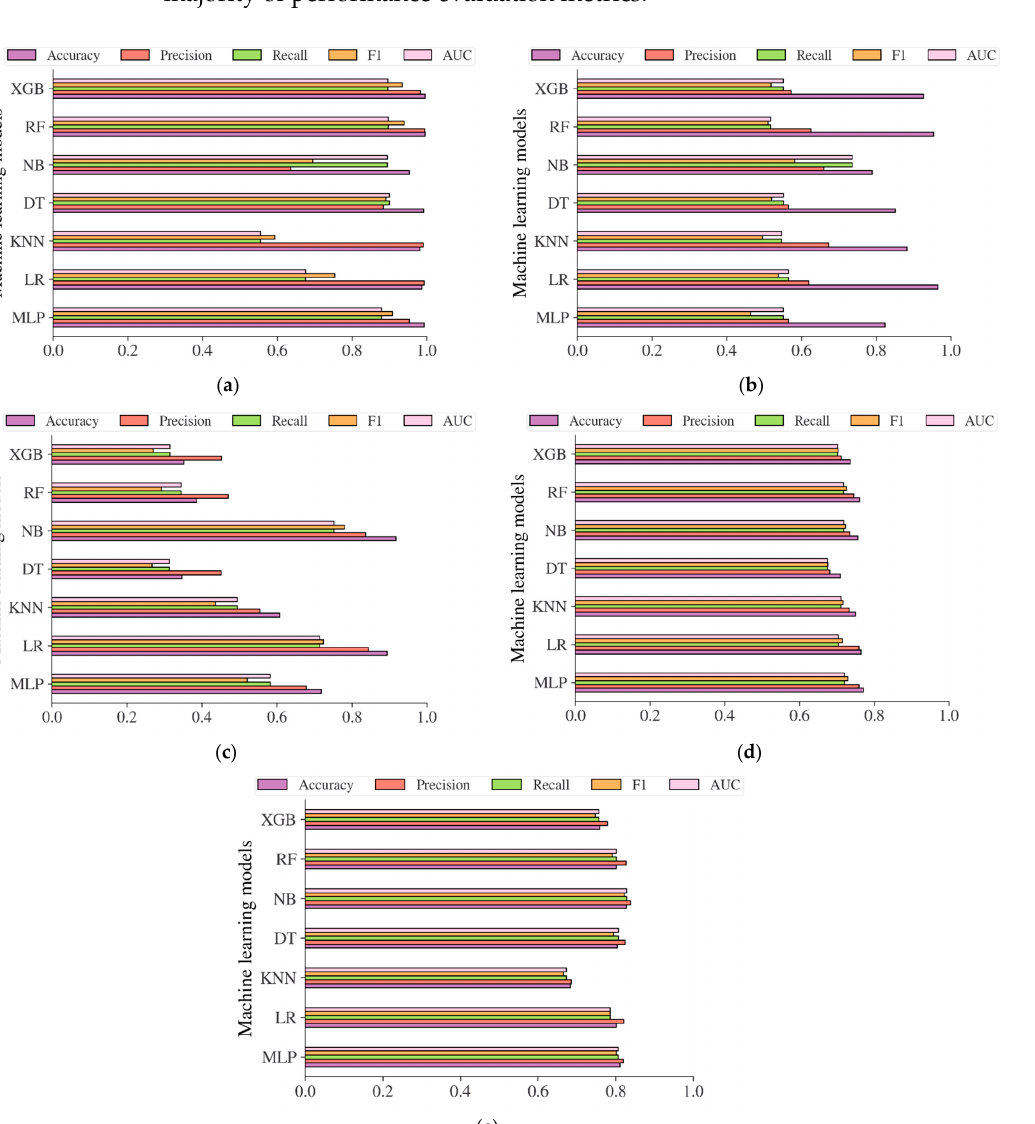
Japanese, ( c ) Korean, ( d ) US-PIMA Indian, and ( e ) Trinidadian adult population samples. Figure 12. The results of diabetes prediction based on machine learning models on ( a ) Chinese,